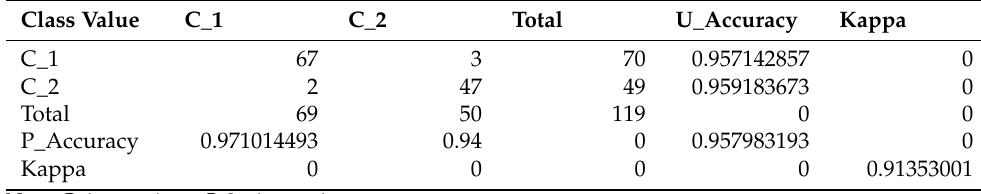
Table 6. Confusion Matrix (ML method).